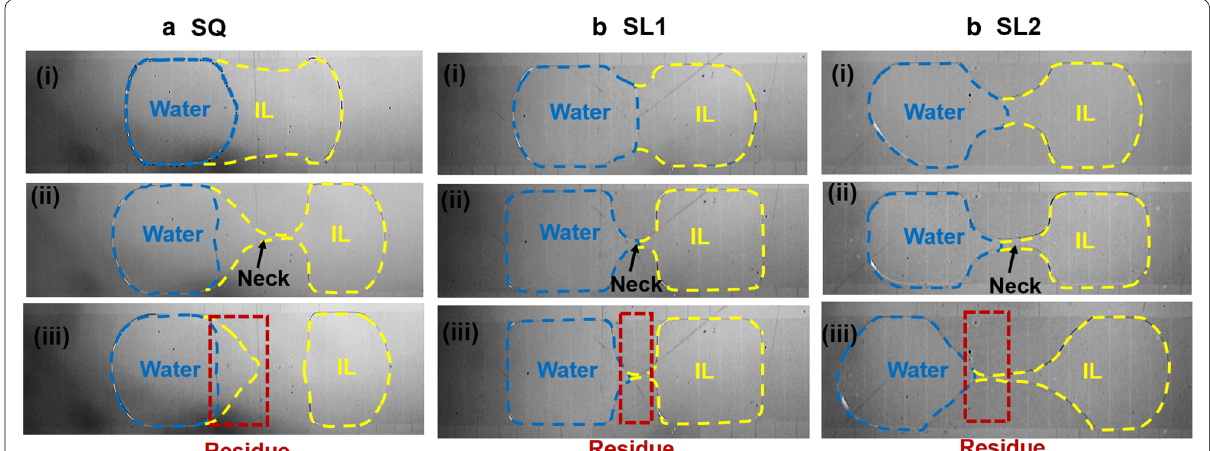
Fig. 8 Profiles of droplet deformation during the phase separation process. a SQ scheme, b SL1 scheme, and c SL2 scheme